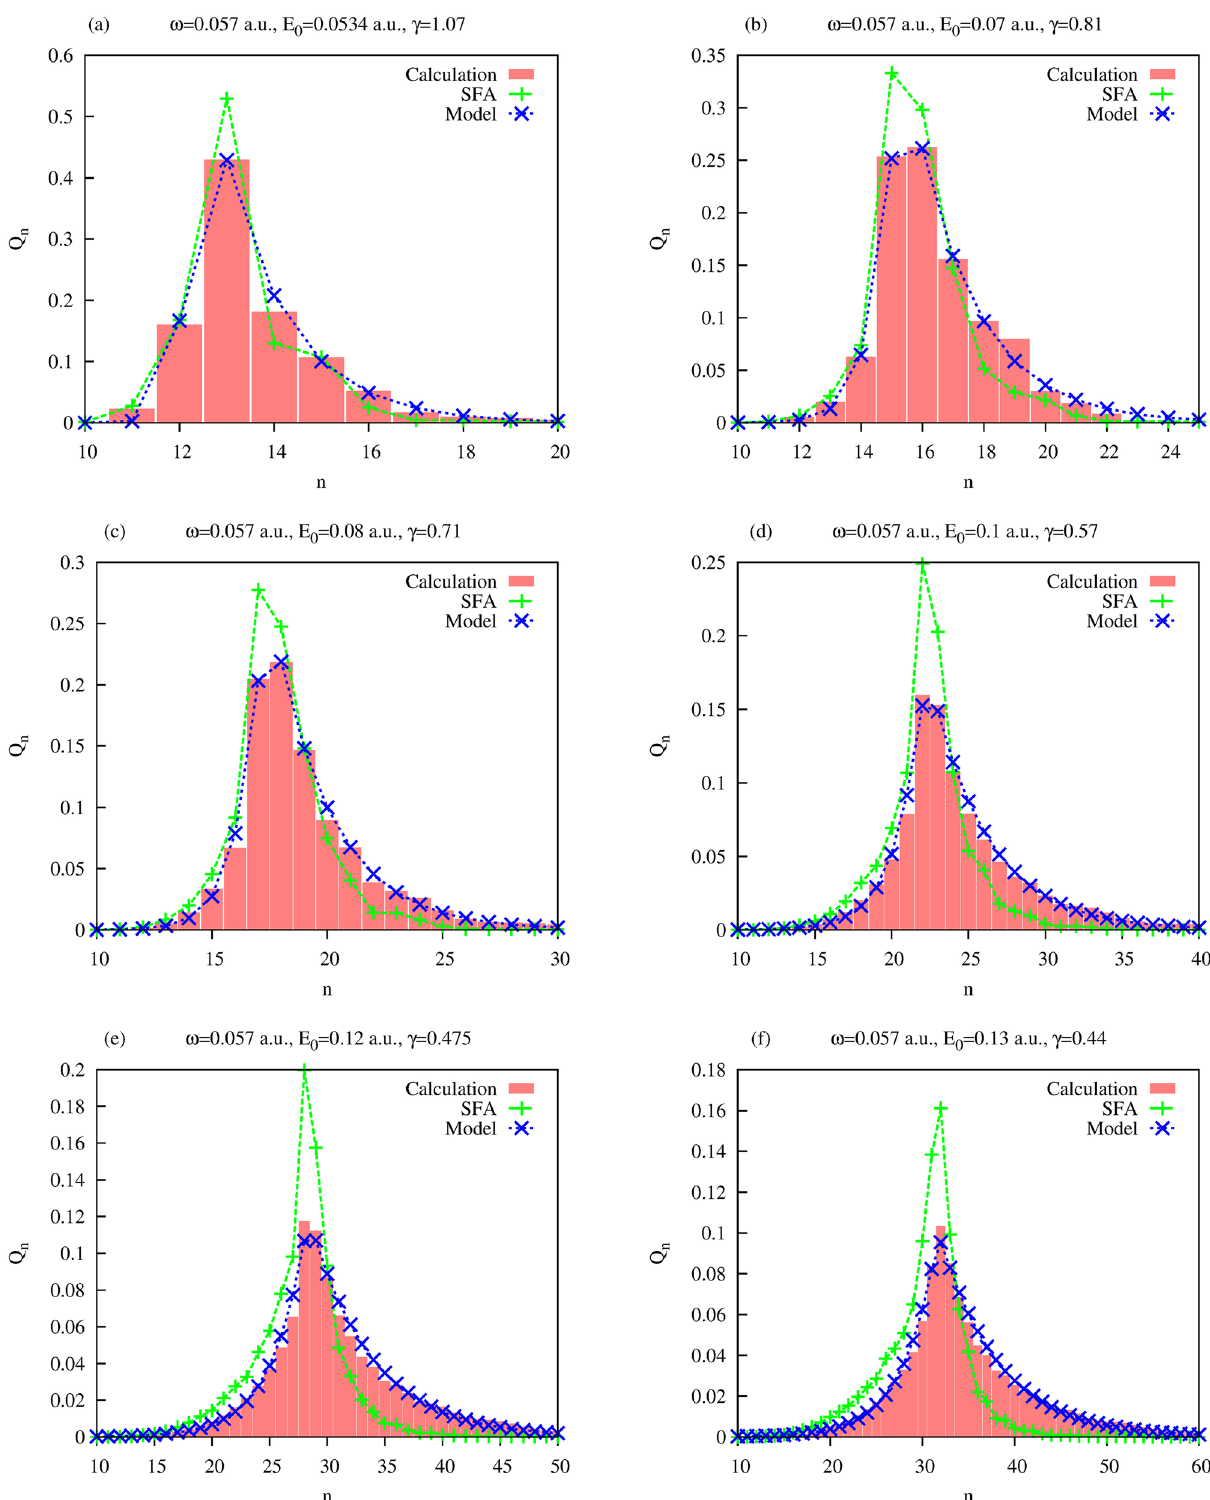
Figure 1. Distributions of absorbed photons, Q n . Also shown are SFA distributions obtained using Eq. (17), and distributions obtained using the stochastic model based on Eqs. (8) and